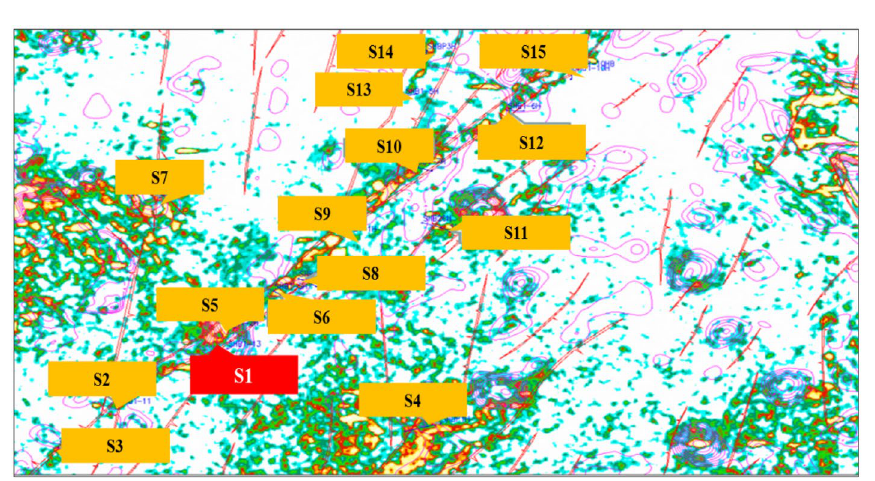
Figure 19. The location of the well